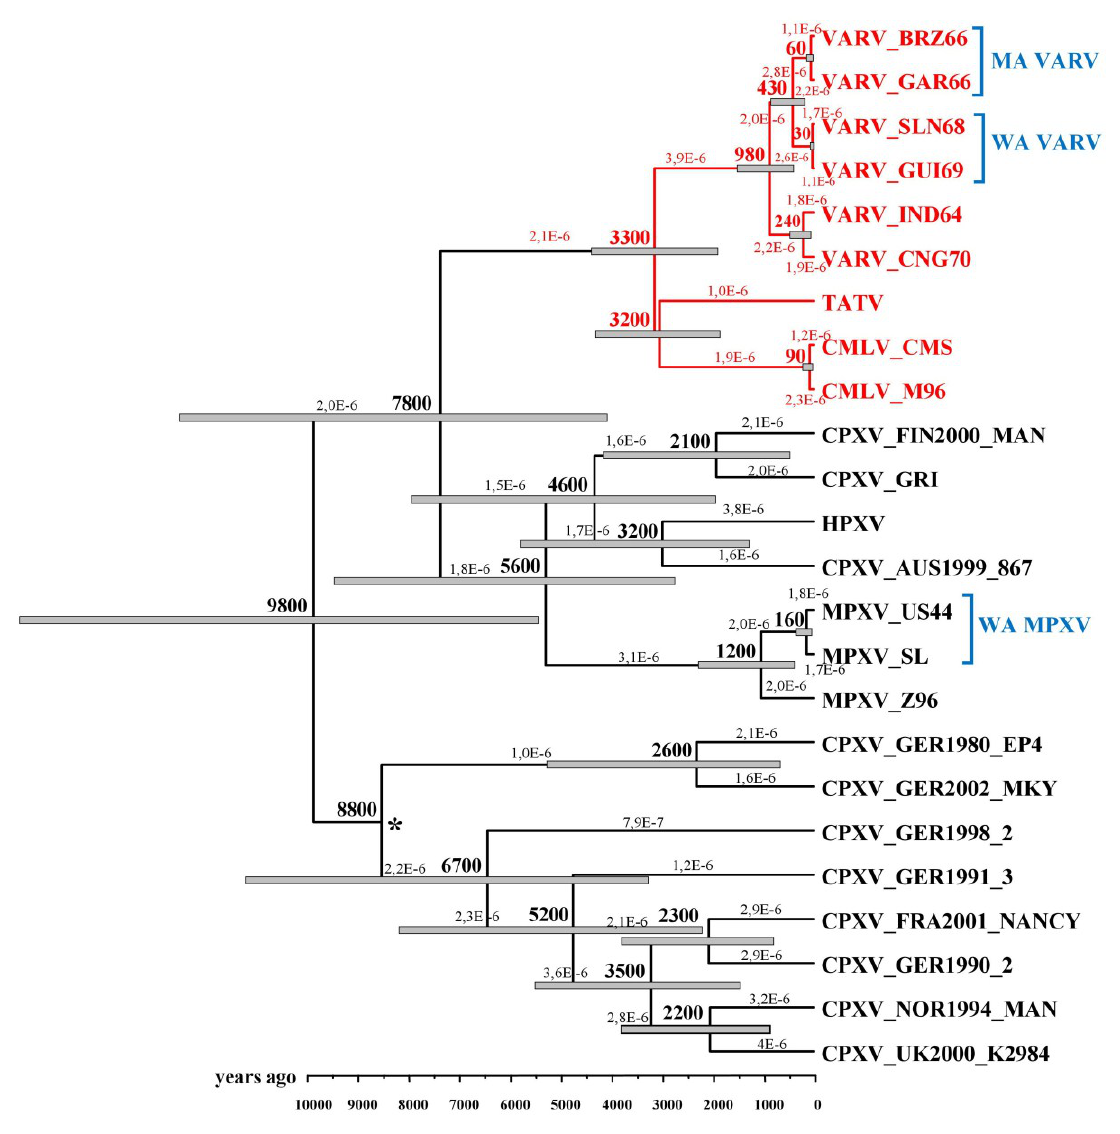
Figure 2. Chronogram of the maximum credibility tree for the orthopoxviruses generated with BEAST based on the central conserved regions of their genomes. The gray bars at the nodes represent the 95% highest probability density intervals. The rates of mutation accumulation are shown near the branches (substitutions/site/year). The numbers on nodes indicate the time to the most recent common ancestor of the clades (years ago). The posterior probabilities of all clades are >90% with the exception of the node marked with an asterisk. VARV—variola virus, TATV—taterapox virus, CMLV—camelpox virus, CPXV—cowpox virus, HPXV—horsepox virus, MPXV—monkeypox virus, MA VARV—variola minor alastrim strains, WA VARV—West African variola virus strains,